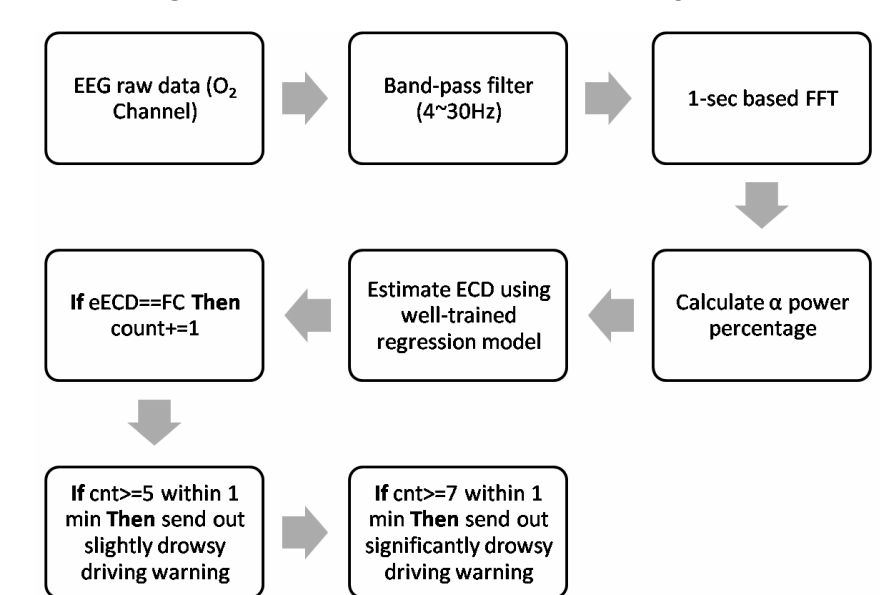
Figure 16. AnovelEEG-based PERCLOS